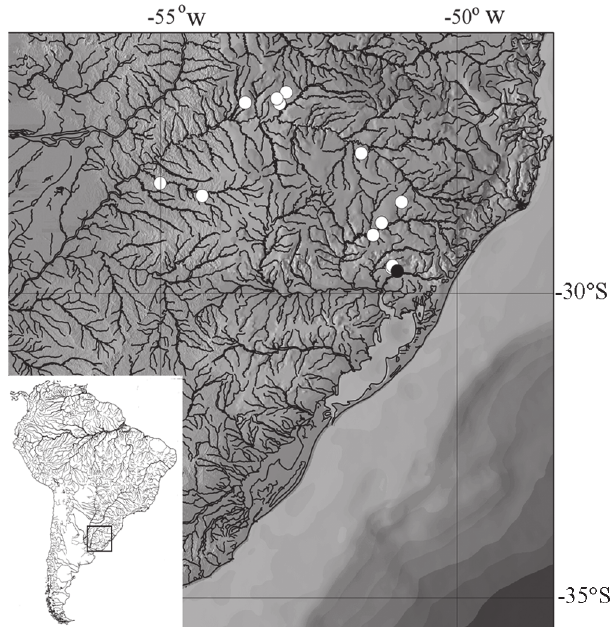
Fig. 9. Map of southern Brazil and Uruguay, showing the distribution of the material examined of Astyanax xiru . Some symbols represent more than on lot or locality. Black circle = type